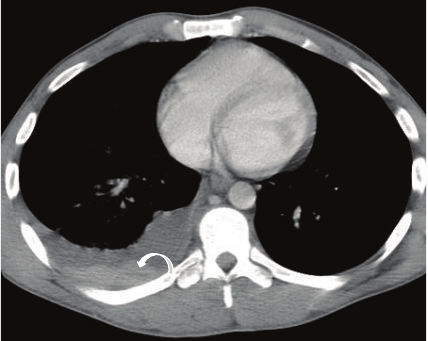
Figure 7: Hemopericardium and bilateral hemothorax. Postcon- trast axial MDCT of a polytraumatized patient reveals a pericardial (curved arrow) and a bilateral pleural effusion (straight arrows), with high attenuation consistent with fresh blood content.